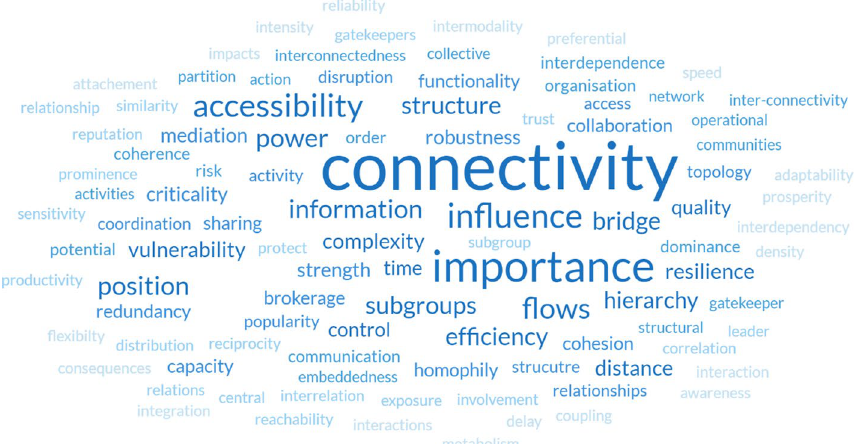
Table 3 Top 8 characteristics with frequency Characteristic Frequency Associated metrics Connectivity 34 Importance 20 Accessibility 12 Influence Flows Information